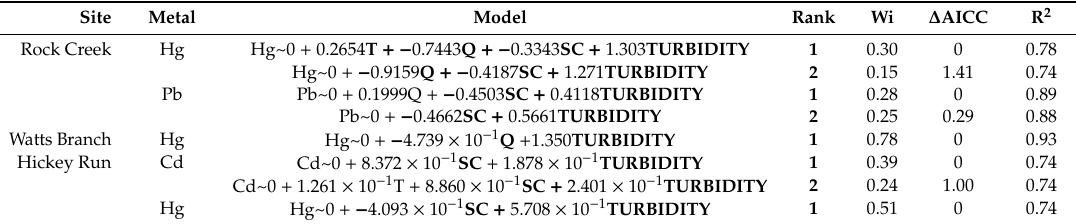
Table 3. Multiple linear regression models chosen with Akaike’s Information Criterion predicting metals concentrations for Rock Creek, Watts Branch and Hickey Run watersheds. Rank is the model rank relative to all possible models, Wi is the weighting evidence or the probability of that model being the best model, and the adjusted R 2 is the correlation coe ffi cient adjusted for the addition of parameters. Parameters in bold were found to be statistically significant ( p < 0.05).